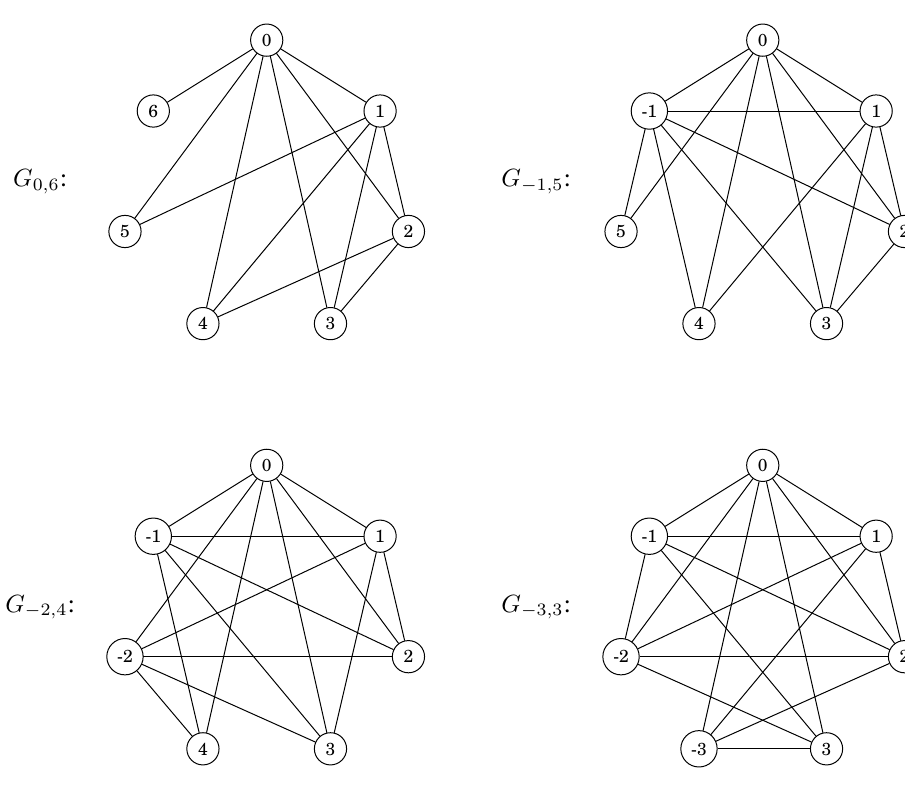
Figure 12: Sum graphs of